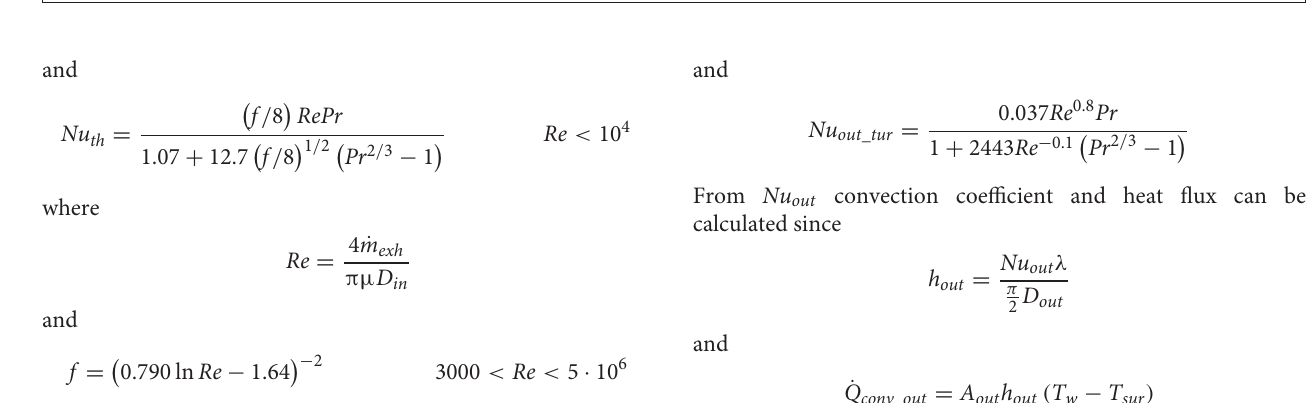
FIGURE 1 | Schematic of the exhaust manifold